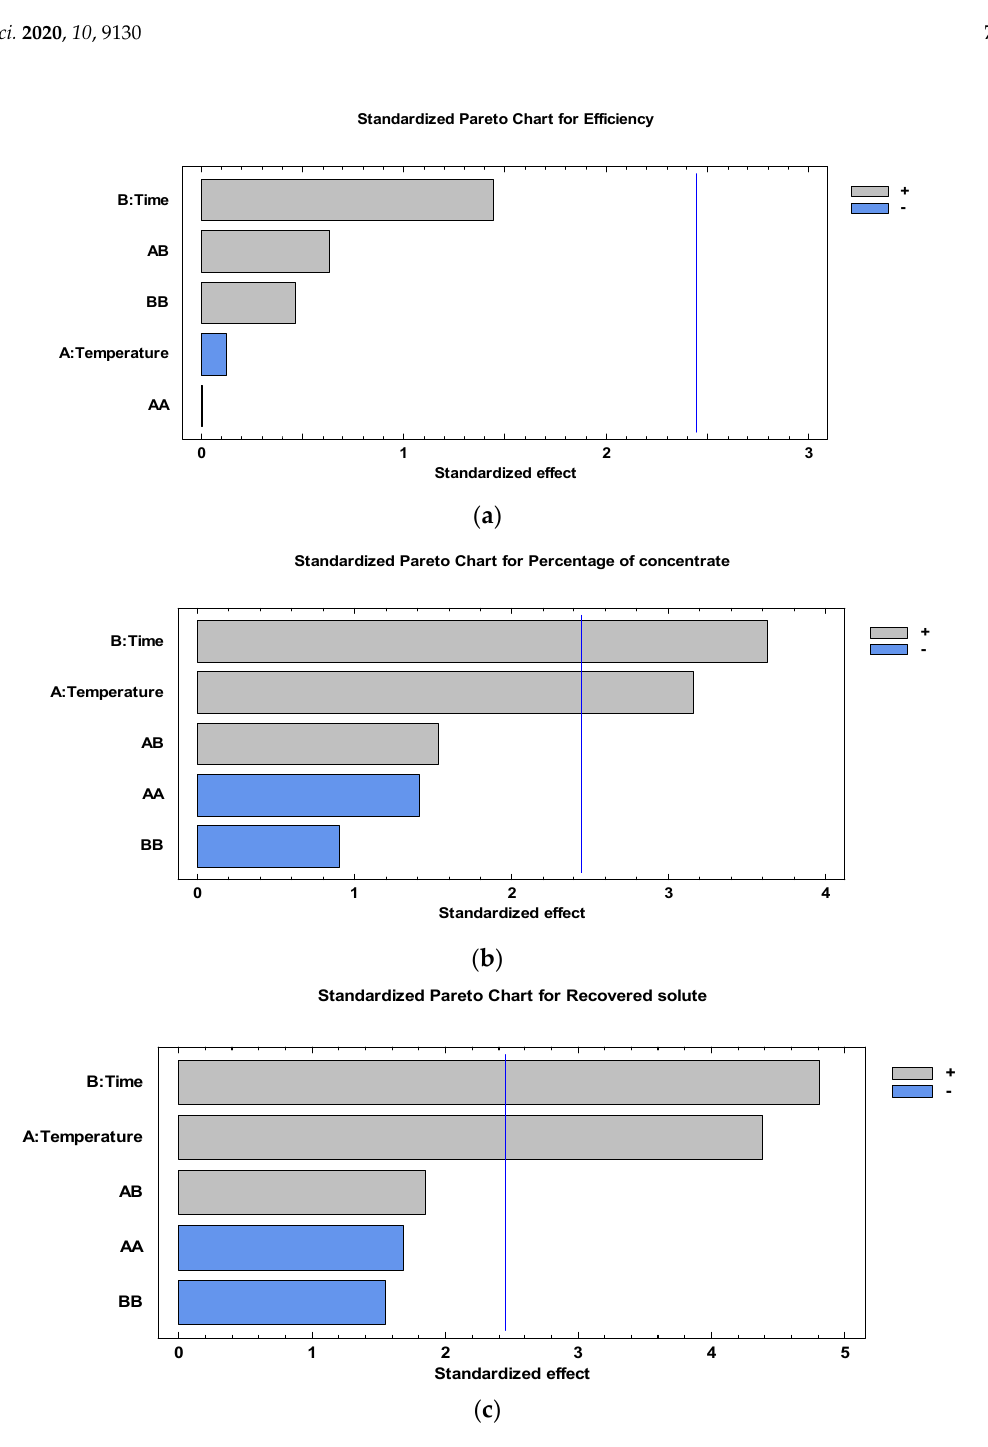
Figure 4. Effect of temperature and time on the ( a ) efficiency, ( b ) percentage of concentrate and ( c ) Figure 4. E ff ect of temperature and time on the ( a ) e ffi ciency, ( b ) percentage of concentrate and recuperated solute. ( c ) recuperated